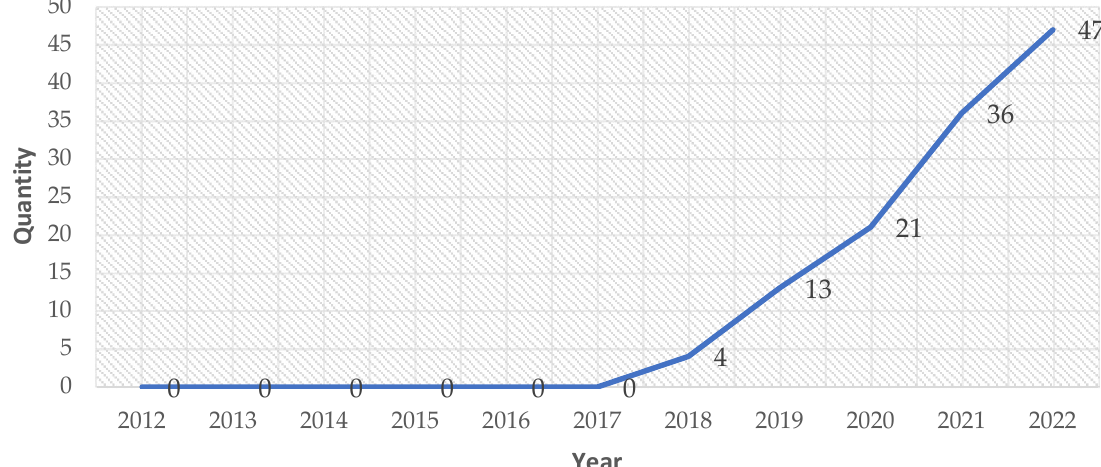
Figure 4. The number of annual publications between 2012 and 2022.